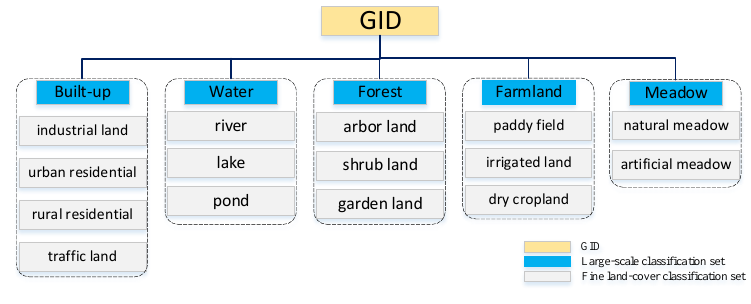
Figure 4. Gaofen Image Dataset (GID) dataset